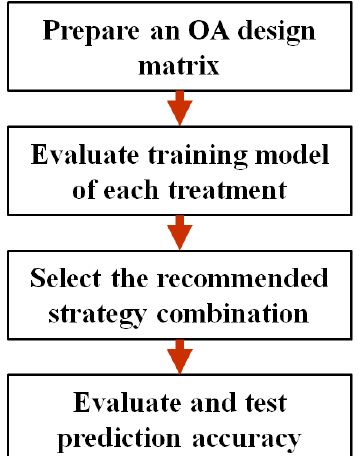
Figure 3. The flowchart of the proposed methodology.